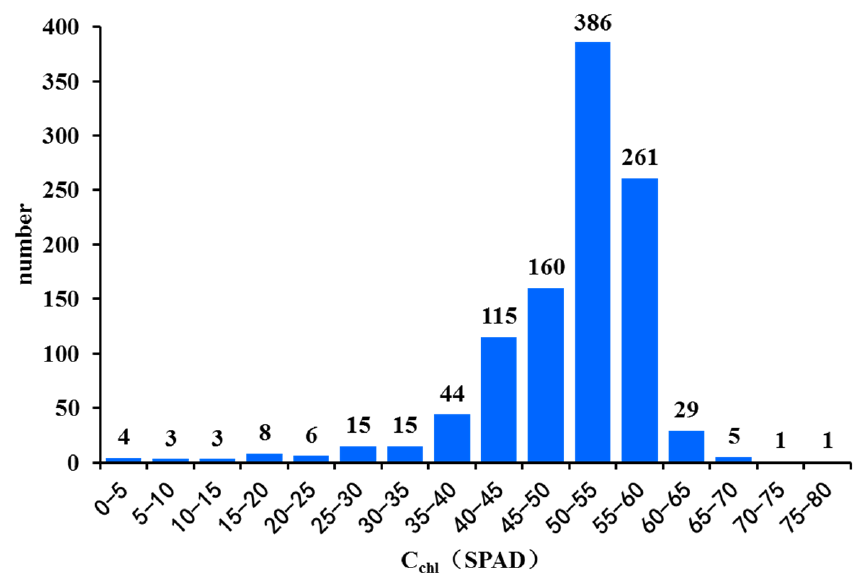
Figure 17. SPAD value distribution. Table 7. The estimation results of different SPAD value ranges.